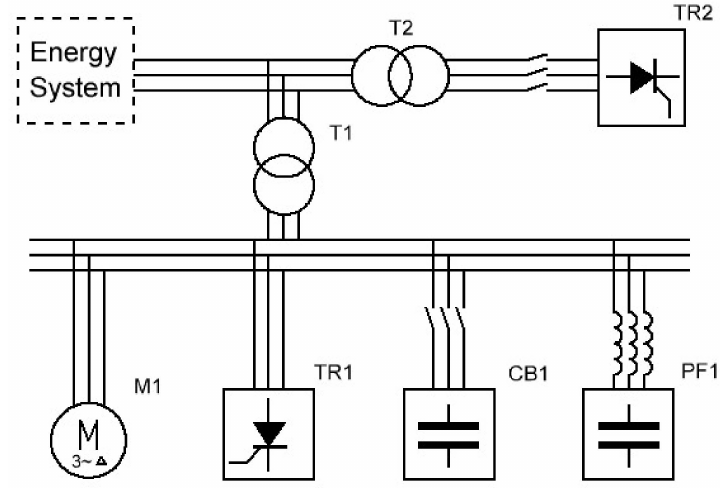
Figure 3. The scheme under study. The equivalent circuit parameters are presented in Table 1. Table 1. The parameters of the equivalent